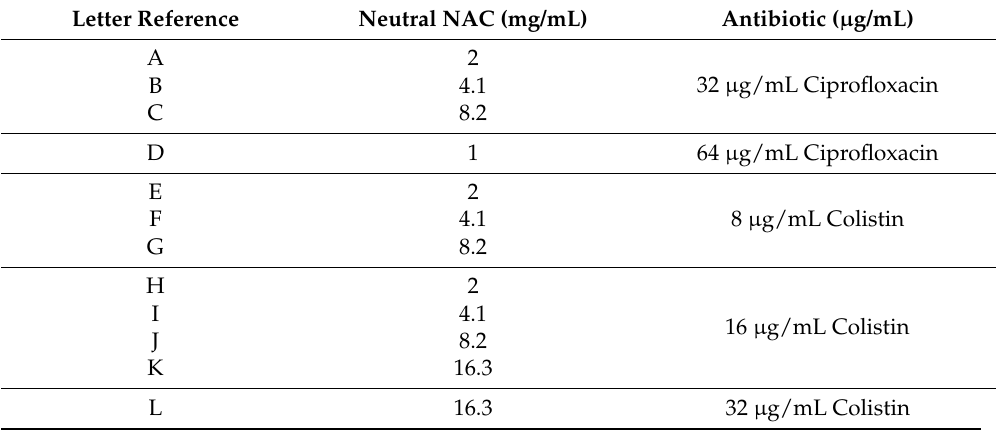
Table 3. Combinations tested with letter references used in text. Combinations selected based on synergistic and additive effects observed during FICI